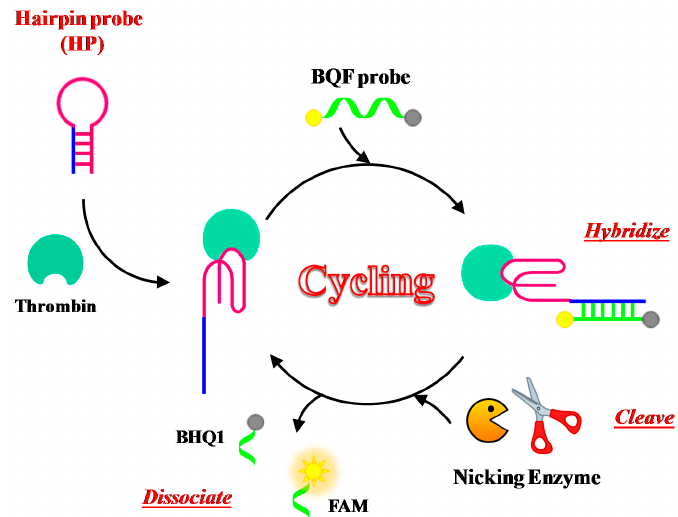
Figure 12. Schematic representation of the fluorescence thrombin detection based on NEase-assisted cyclic enzymatic signal amplification (CESA), as described in reference [113]. The cleavage of the BQF (BHQ-quenching fluorescence) probe by nicking endonuclease regenerates the fluorescence signal. FAM = 6-carboxyfluorescein; BHQ1 = Black Hole Quencher 1.